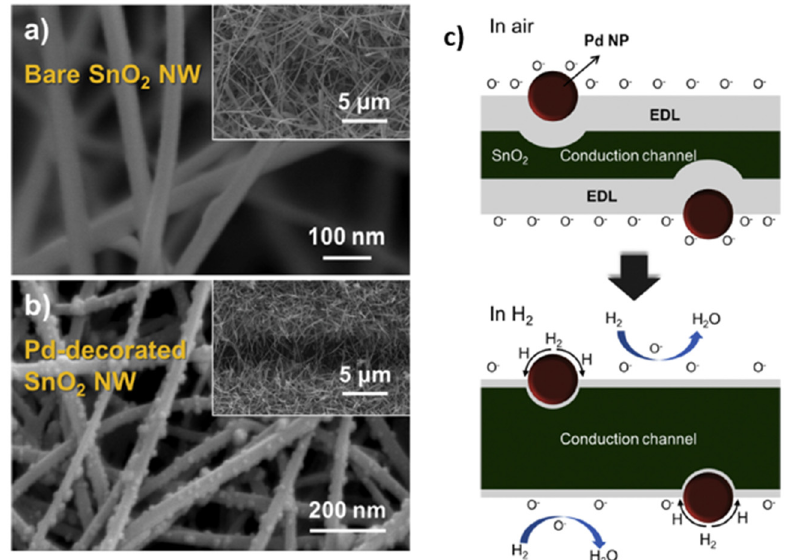
Figure 17. Field-emission scanning electron microscope (FE-SEM) micrographs of ( a ) bare SnO 2 NWs and ( b ) Pd-decorated SnO 2 NWs. Upper-right inserts are the top-view of the FE-SEM images. ( c ) The sensing mechanism of Pd-decorated SnO 2 NWs [87]. Copyright (2017), with permission from Elsevier.